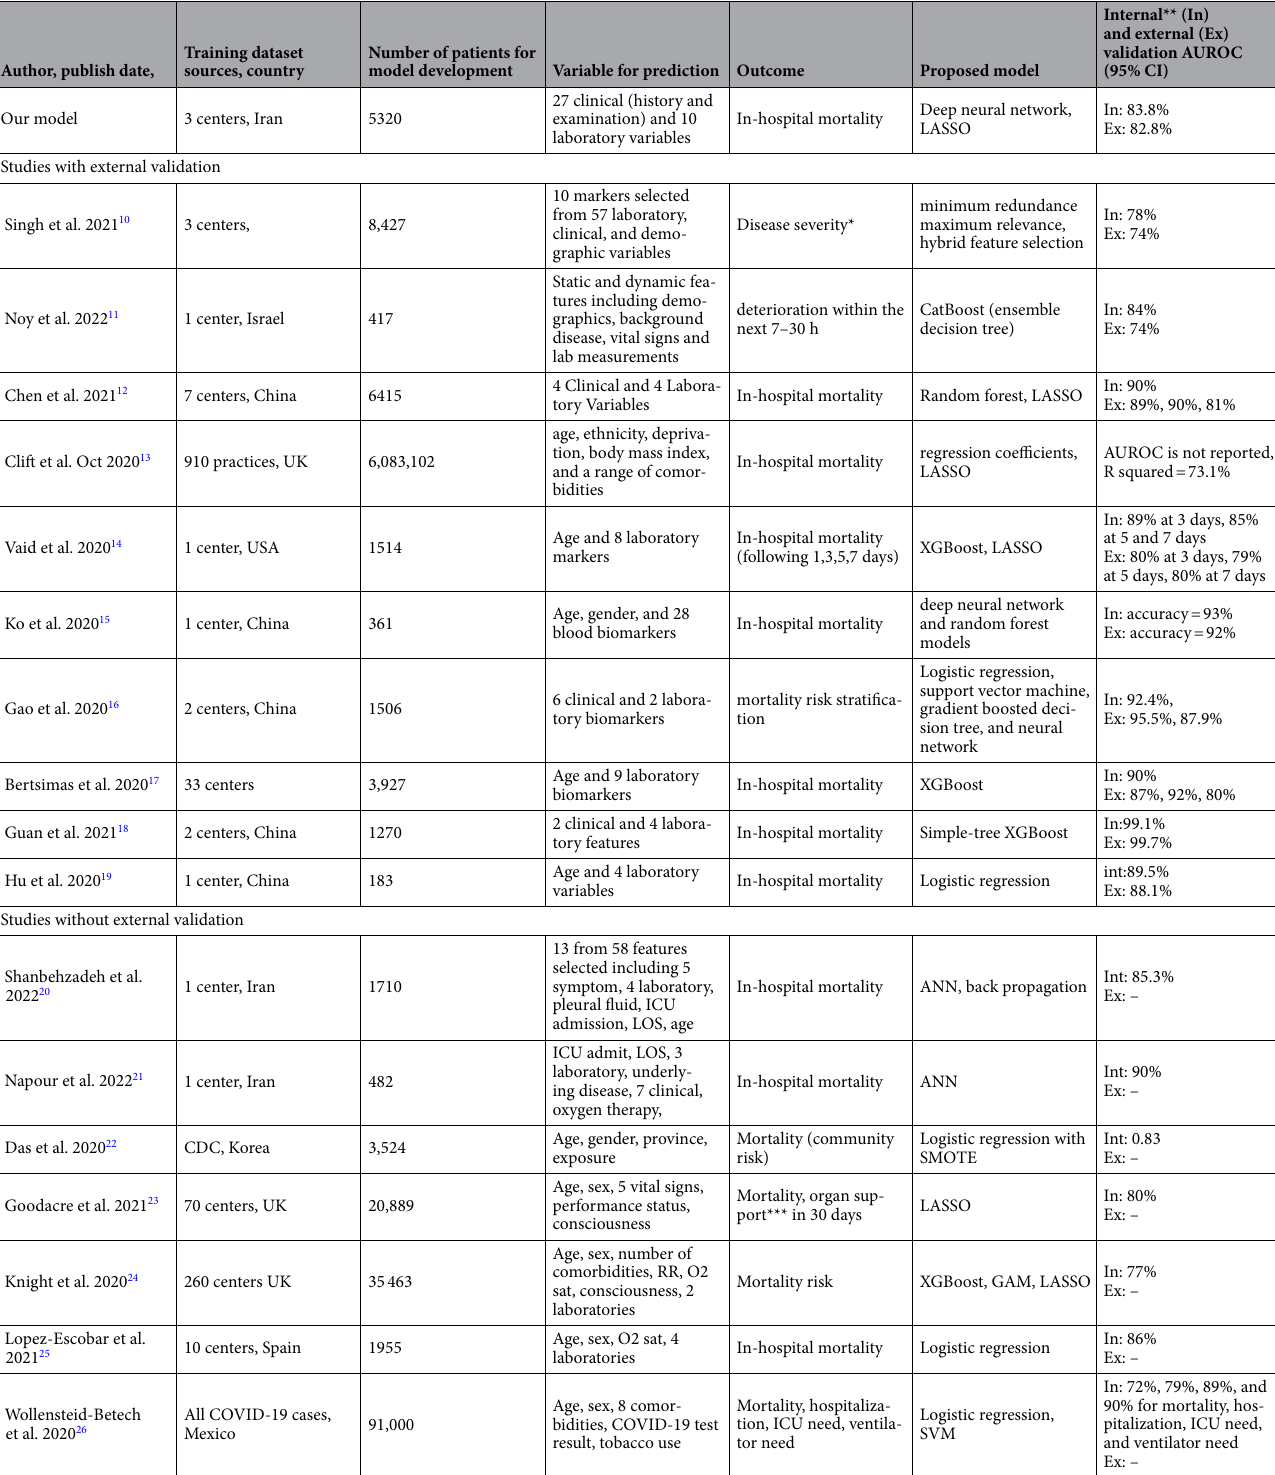
Table 1. Studies with or without external validation aiming to predict prognosis of COVID-19 using clinical and laboratory features (retrieved from review articles and search in PubMed and Scopus databases 7,9 ). LOS length of stay, ICU intensive care unit, AUROC area under the receiver operating characteristic, LASSO least absolute shrinkage and selection operator, ANN artificial neural network, SMOTE synthetic minor oversampling technique, RR respiratory rate, SBP systolic blood pressure, GAM generalized additive model. *Severity level 0 (no respiratory problem) to level 4 (in-hospital ≤ 30-day mortality). **For internal validation the evaluation metrics on test model was retrieved. ***Organ support assumed as need for respiratory, renal, or cardiovascular